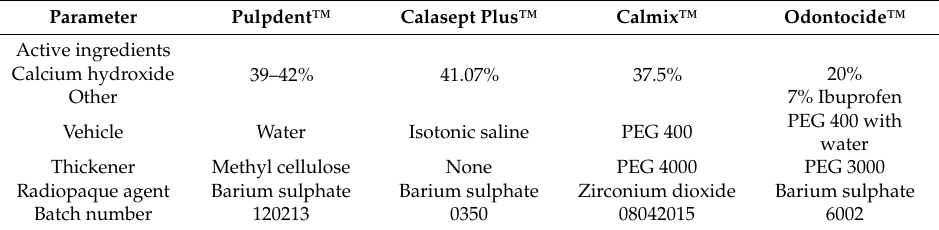
Table 1. Components of commercial calcium hydroxide